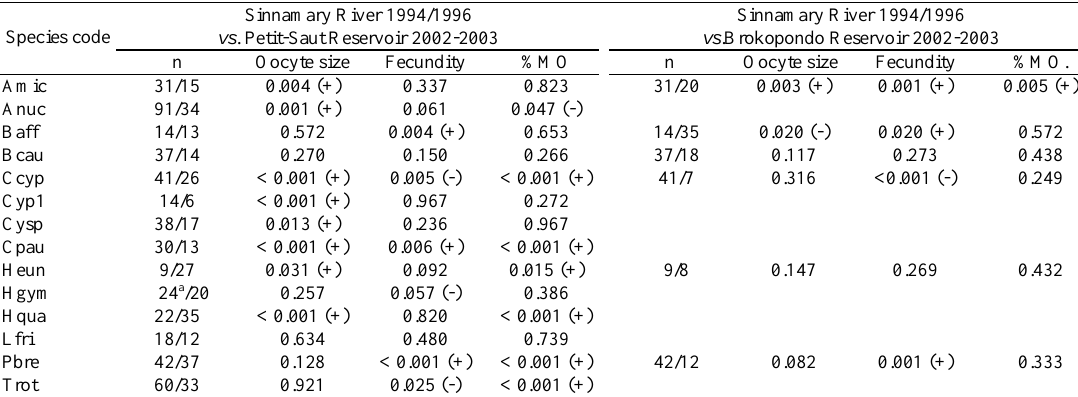
Table 3. Probabilities associated with the partial correlation of oocyte size, fecundity and percentage of mature oocytes in the gonad (%MO) with site/period. Direction of change in parentheses. In column “n” the first number is the number of observations from 1994/1996 and the second the number of observation from 2002/2003. “ a ” = observations on life-history traits of H . gymnorhynchus included specimens from the section downstream from the dam prior to dam